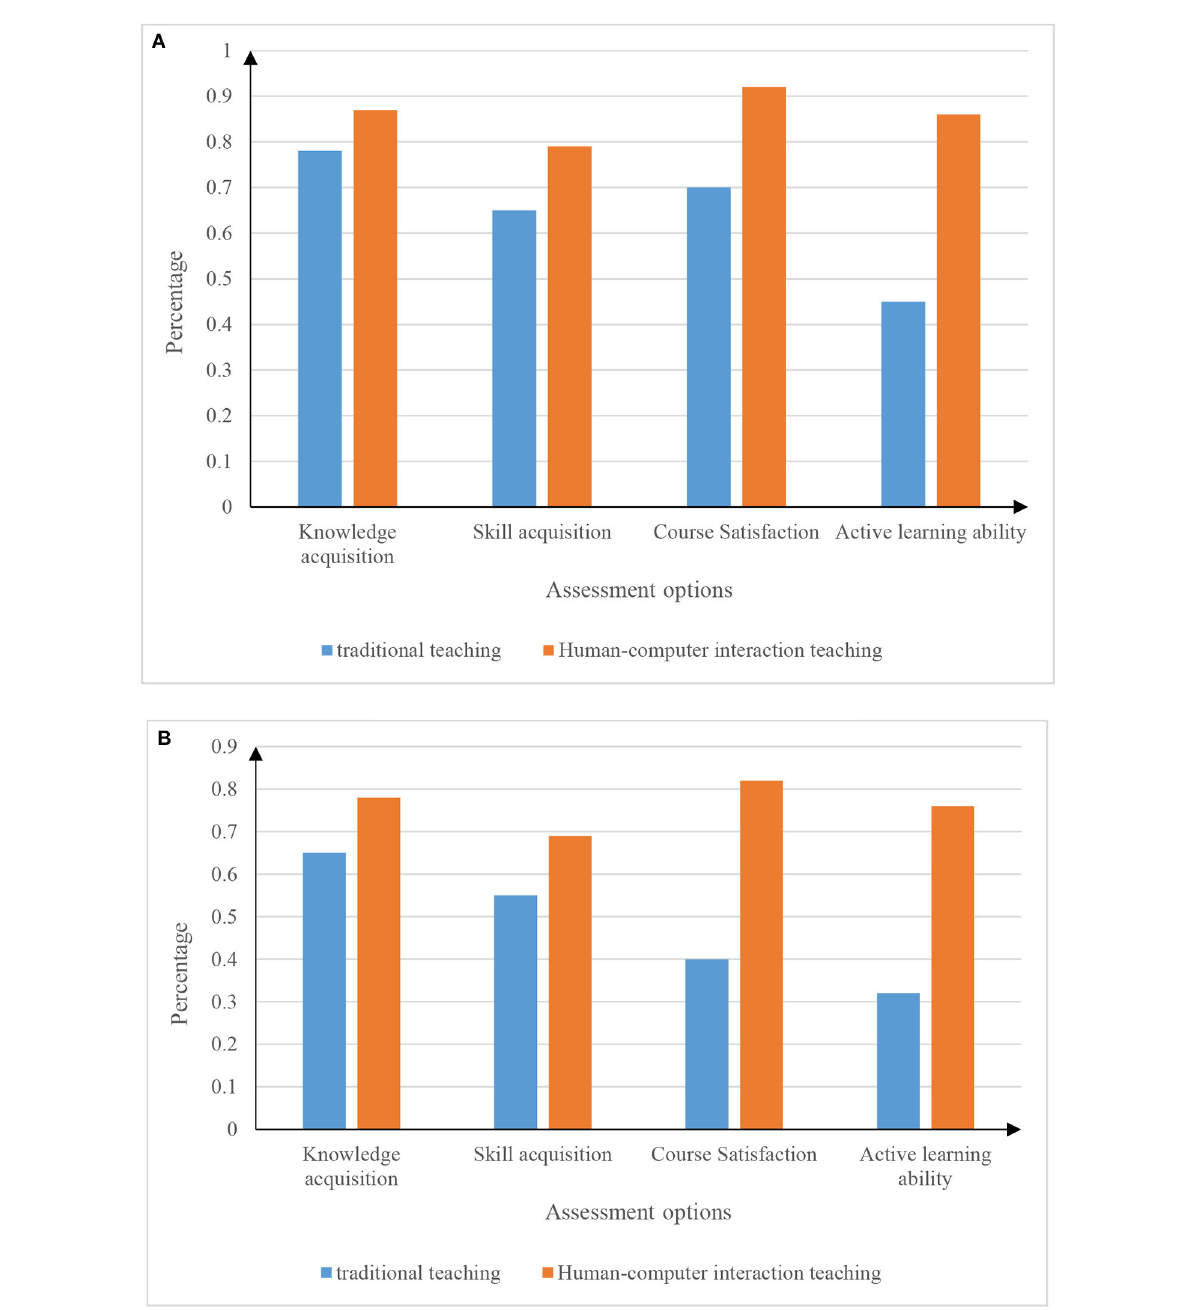
FIGURE9 Basketball teaching situation in different grades. (A) Senior basketball teaching situation map. (B) Lower grade basketball teaching situation map.